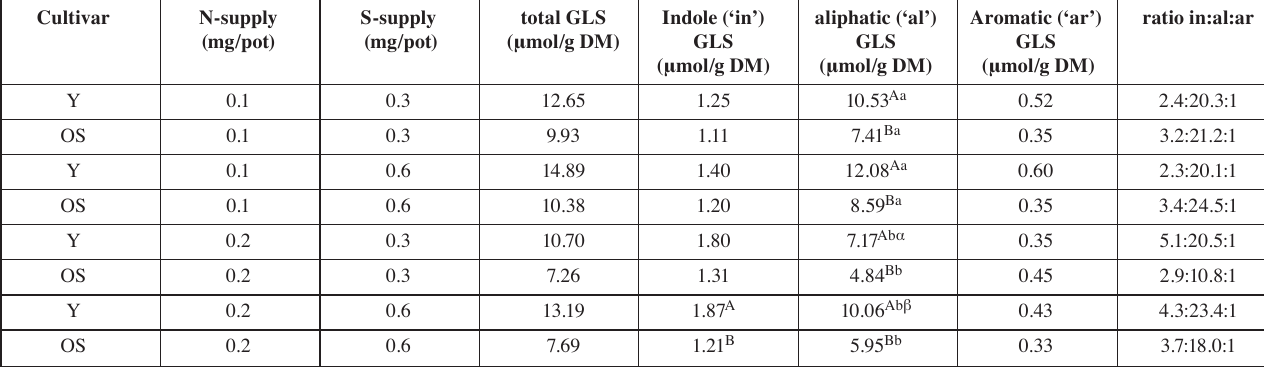
Tab. 2: GLS concentration, indole GLS concentration, aliphatic GLS concentration, aromatic GLS concentration and the GLS ratio of different nutrient sup- ply variation in Chinese cabbage cvs. Yuki (Y) and Orient Surprise (OS). Only significant differences were presented with uppercase letters represent significant differences between the cvs., lower case letters represent significant differences between the N treatments, and Greek letters significant differences between the S treatments (P < 0.05).